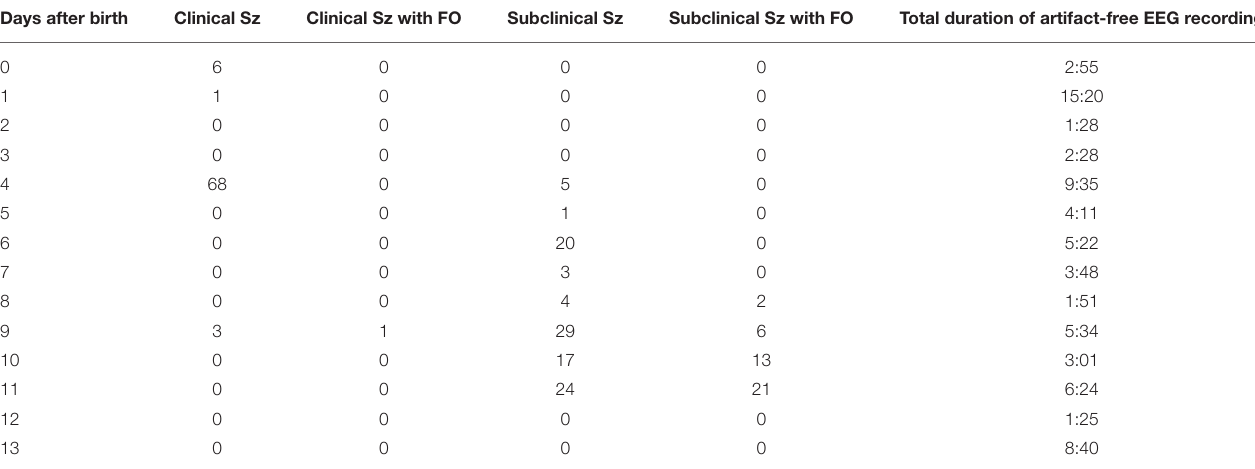
TABLE 1 | Numbers of seizures in artifact free EEG records. Days after birth Clinical Sz Clinical Sz with